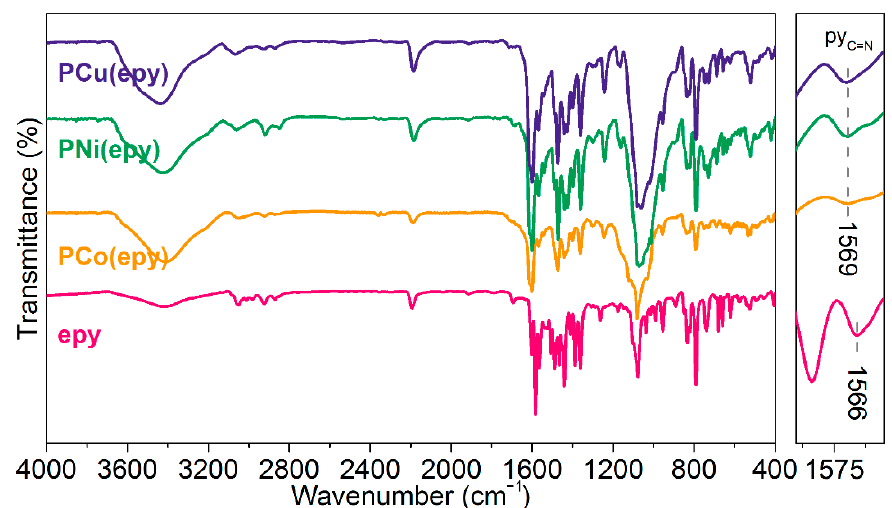
Figure 2. FTIR spectra of PM(epy) . Expansion (right): the spectral region involving the absorption of C=N bond from the pyridine ring.